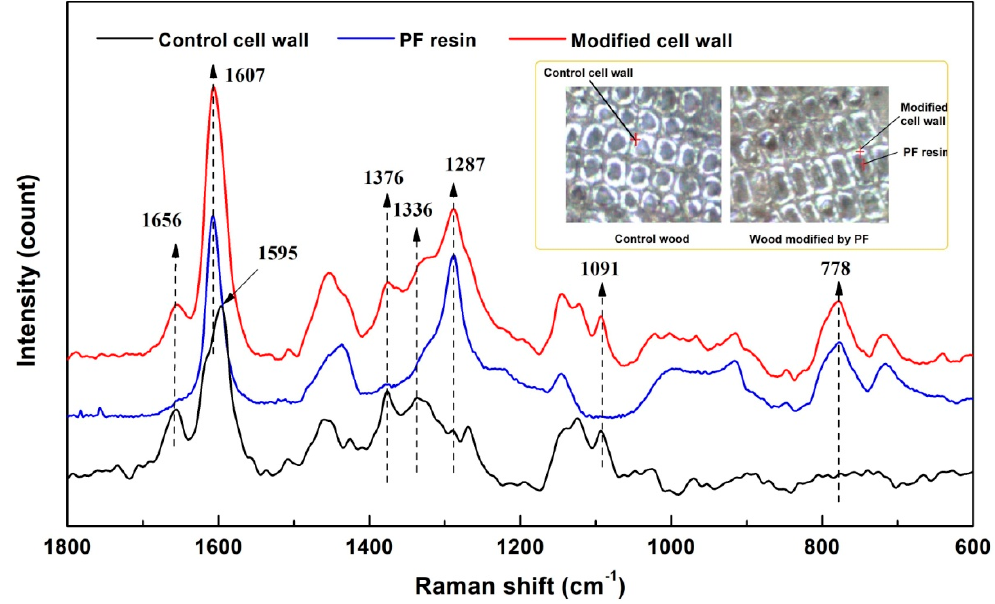
Figure 4. Raman spectra of the control and modified wood.